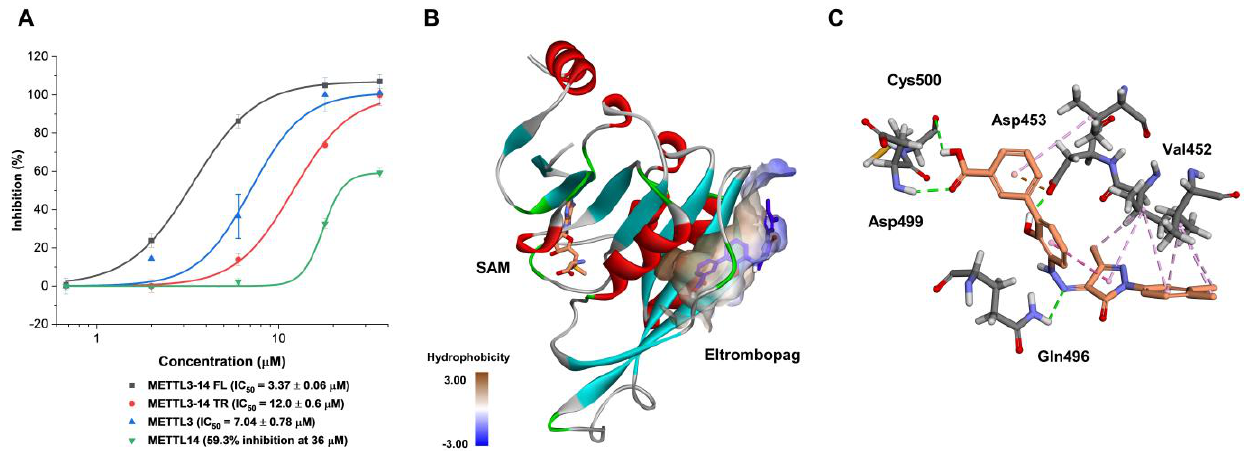
Figure 5. Predicted binding mode of eltrombopag with the METTL3 crystal structure. ( A ) Inhibitory activities of eltrombopag in various METTL3-14 enzyme forms (METTL3-14 FL: full length of METTL3-14, METTL3-14 TR: truncated form of METTL3-14 consisting of a methyltransferase do- main). ( B ) Hydrophobicity surface view at the predicted allosteric binding pocket with the docked eltrombopag into METTL3 crystal structure (PDB: 5IL1 A chain). ( C ) Docking pose of eltrombopag with METTL3 (the green dashed lines represent hydrogen bond).